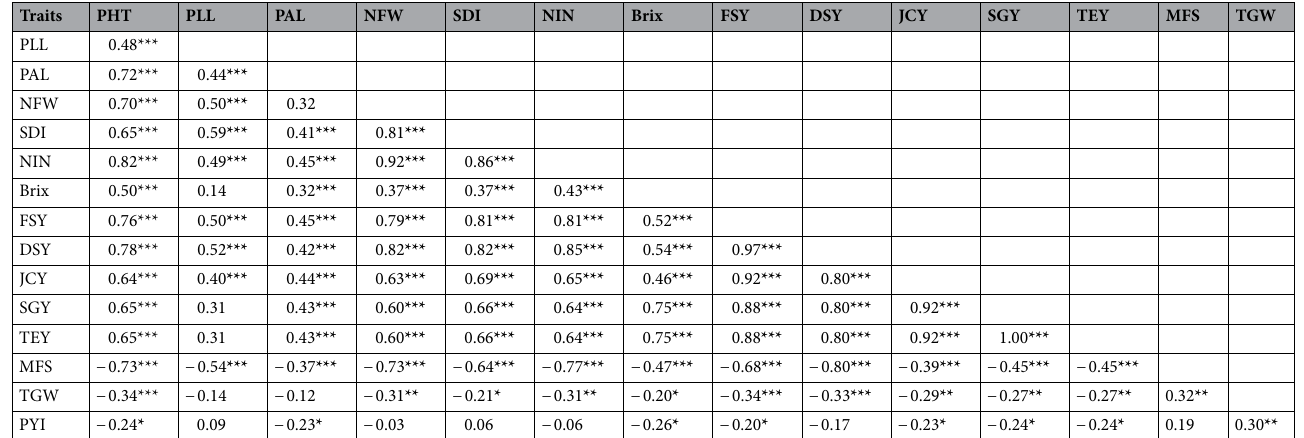
Table 5. Correlation coefficient for agro-morphological and phenotypic characteristics of 105 semi-arid Chadian sweet sorghum accessions. *,**,*** Significance at p < 0.05 , p < 0.01 , p < 0.001 ; PHT: plant height; PLL: perultimate leaf length; PAL: panicle length; NFW: number of days to flowering; SDI: stem diameter; NIN: number of internodes; FSY: fresh stalk yield; DSY: field dried stalk yield; JY: juice yield; SY: sugar yield; TEY: theoretical ethanol yield, MFS: moisture content in fresh stalk; TGW: 1,000-grain weight; PYI: potential